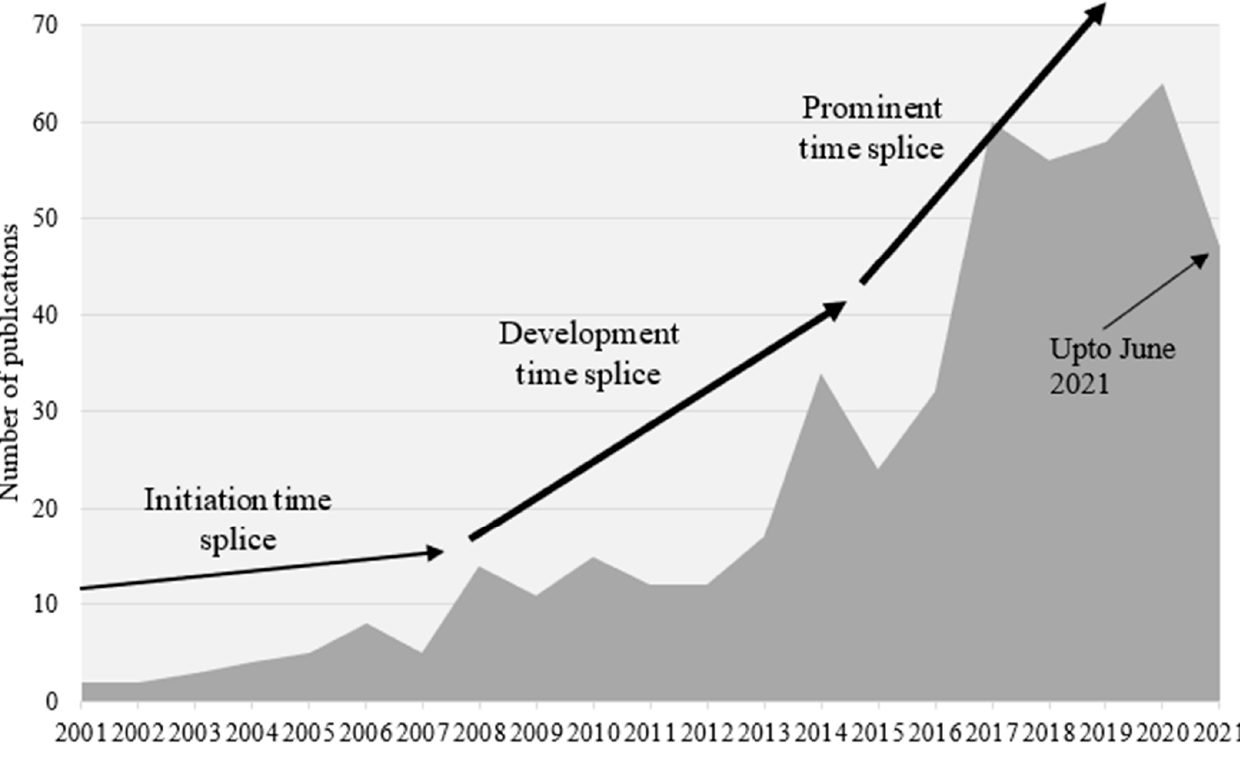
Figure 2. Timeline of related published articles.